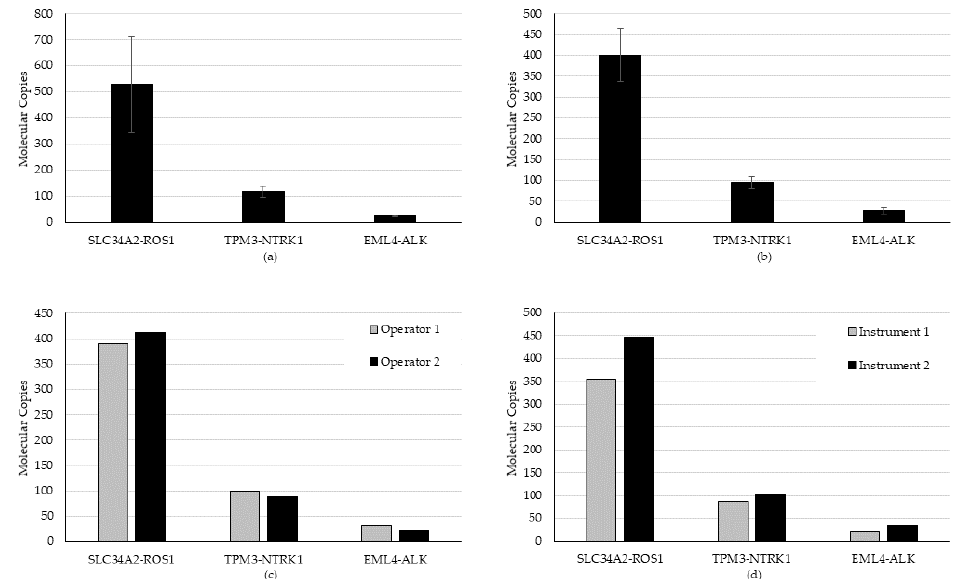
Figure 3. Repeatability and intermediate precision study results for the fusion/skipping variant type. ( a ) Repeatability, ( b ) inter-day, ( c ) inter-operator, and ( d ) inter-instrument variability were evaluated using a high, medium, and low contrived specimen.